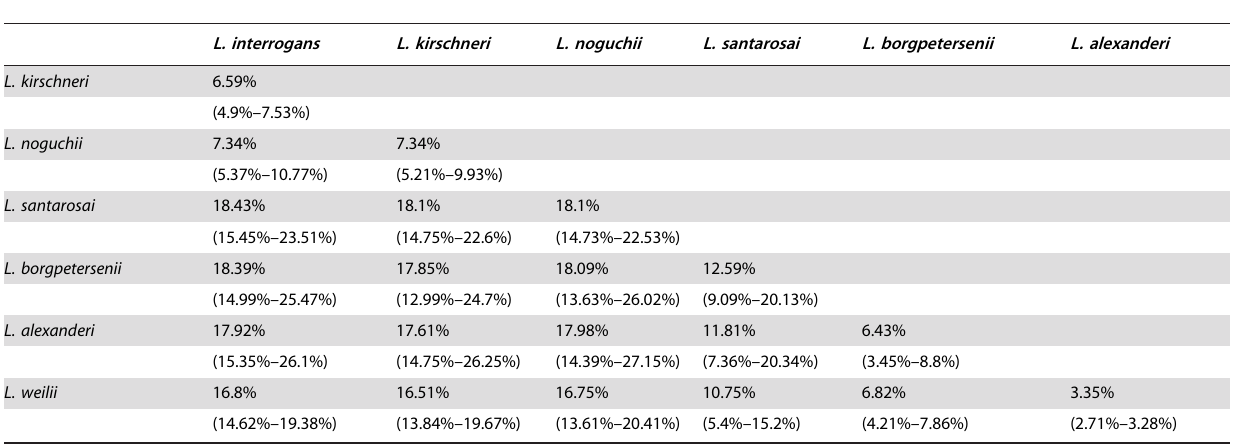
Table 3. Average (range) nucleotide distance based on concatenated sequences of 7 MLST loci.